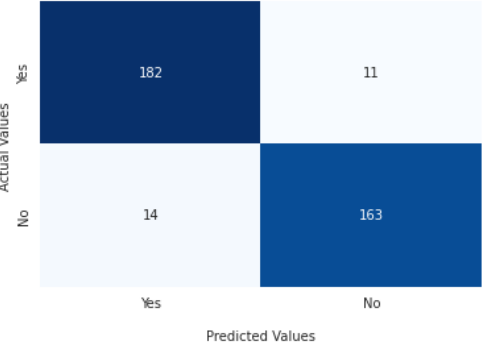
Figure 10. The confusion matrix analysis of the proposed ETC approach.